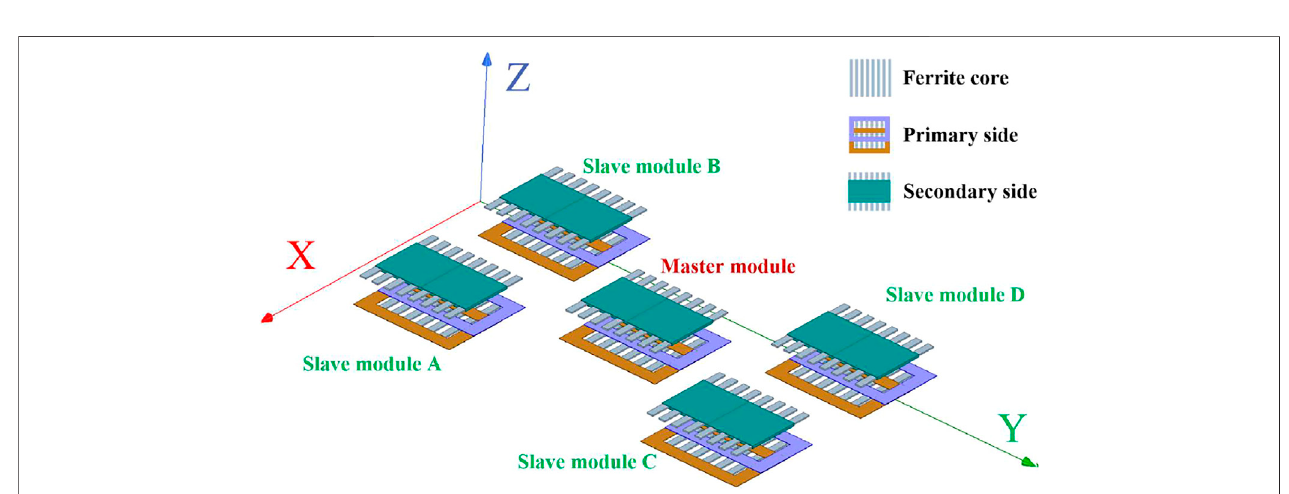
FIGURE 8 | Proposed transformer structure of the modular WPT